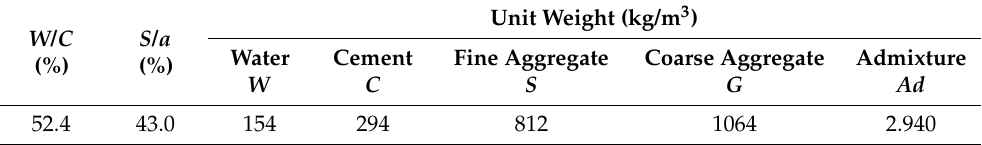
Figure 1. Specimen dimensions and layouts of the rebars and AFRP sheets. Table 3. Concrete mix proportion table.